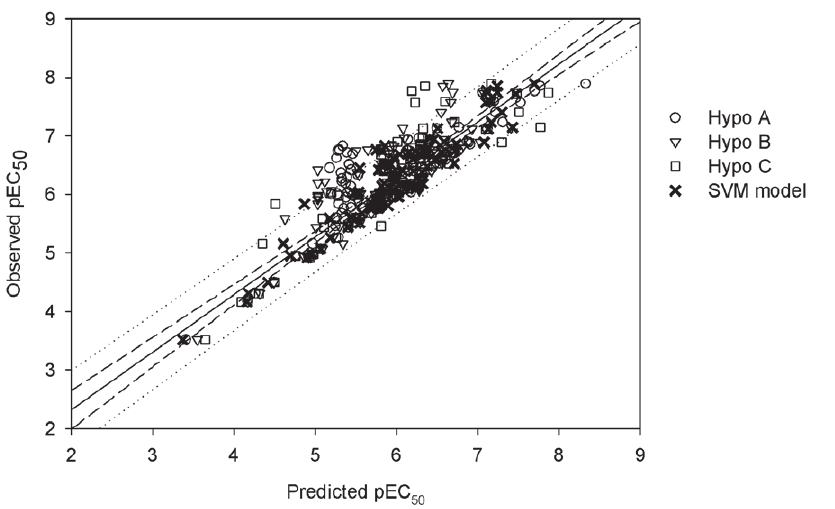
Figure 6. Observed vs. predicted pEC 50 values in the test set. Observed pEC 50 vs. the pEC 50 predicted by Hypo A, Hypo B, Hypo C and SVM model for those molecules in the test set. The solid line, dashed lines and dotted lines correspond to the SVM regression of the data, 95% confidence interval for the SVM regression and 95% confidence interval for the prediction, respectively.